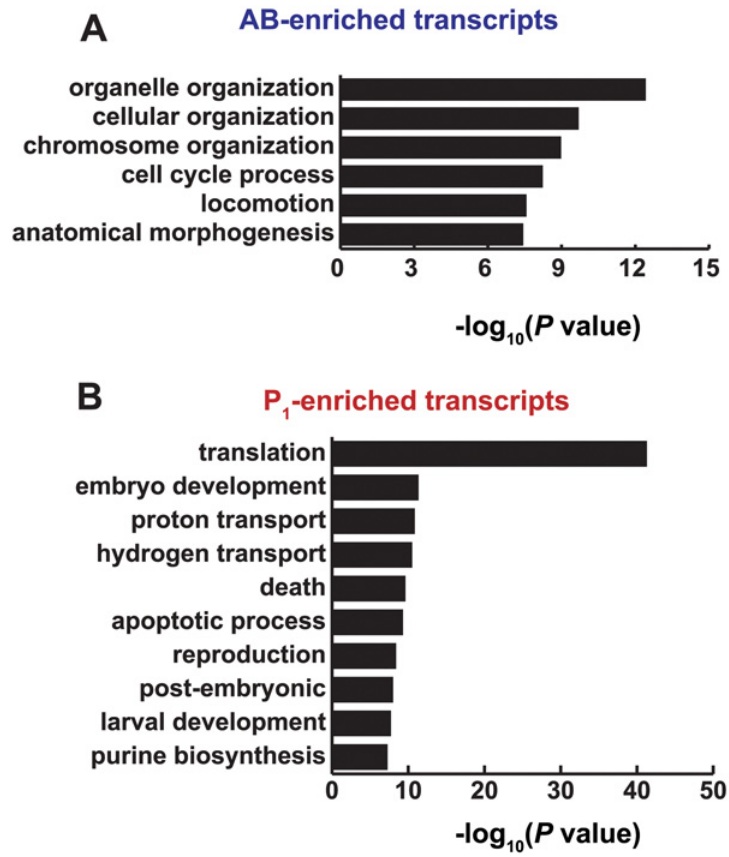
Fig 5. Functions associated with AB and P 1 -enriched transcripts. (A) GO ontology terms over- represented in genes whose transcripts were AB-enriched at the 2-cell stage of development. Categories were identified using the GOrilla algorithm for identifying categorical significance from ranked lists [50] and were summarized using the REViGO algorithm [51]. (B) Same as A for P 1 -enriched.